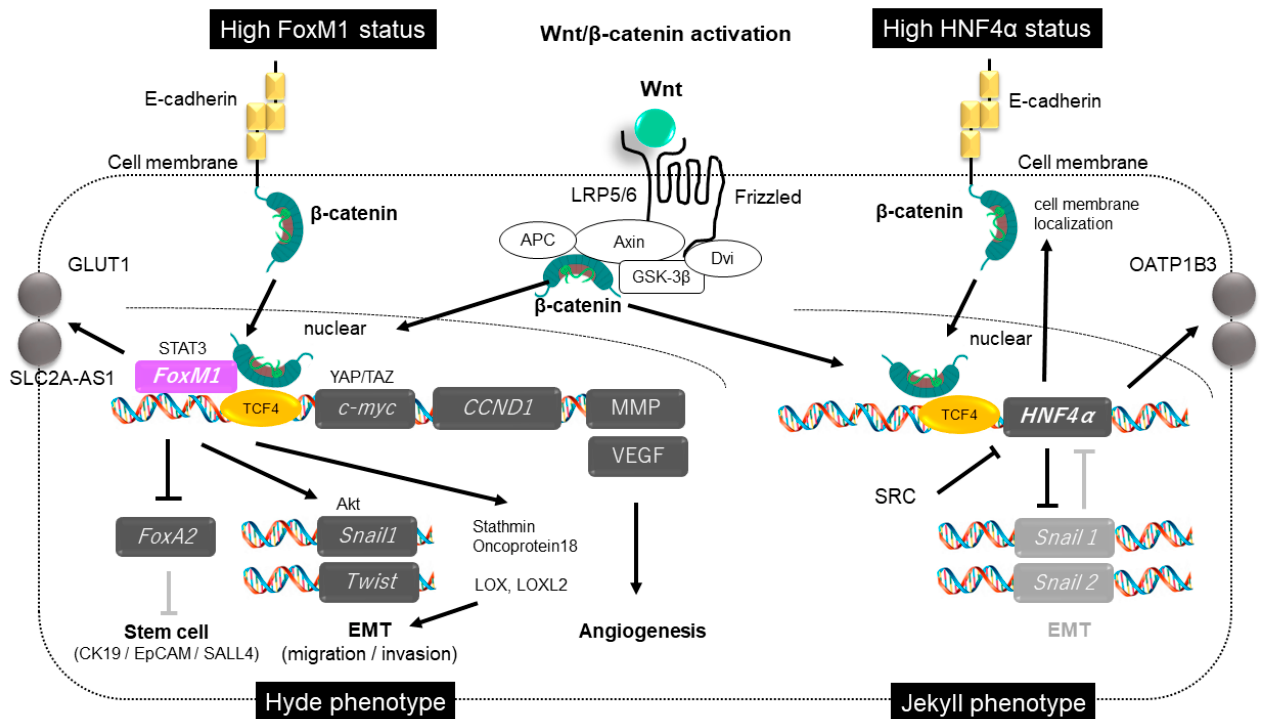
Figure 3. Dual aspects of Wnt/ β -catenin: the Jekyll and Hyde phenotype. ( Left panel ) HCC cells with high FoxM1 status. FOXM1 strongly enhances nuclear translocation of β -catenin in HCC cells. Nuclear shuttling of β -catenin by FOXM1 promotes the transcription of genes such as c-myc and CCND1 . EMT is promoted and stem cell features are acquired, resulting in an aggressive phenotype (Hyde phenotype). FOXM1 is likely to enhance GLUT1 expression. ( Right panel ) HCC cells with a high HNF4 α status. β -catenin translocated into the nucleus promotes the transcription of HNF4 α , represses the transcription of Snail1/2, an EMT-related gene, and increases β -catenin localization to the cell membrane, resulting in a non-aggressive phenotype (Jekyll phenotype). HNF4 α increases OATP1B3 transporter expression.